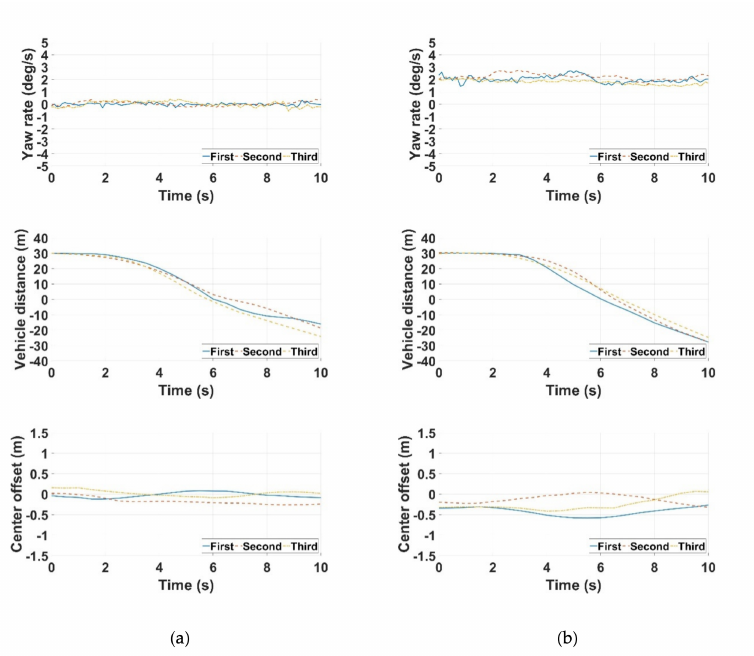
Figure 11. Yaw rate, distance to the lead vehicle, and distance to the center of the lane: ( a ) scenario 11 and ( b ) scenario